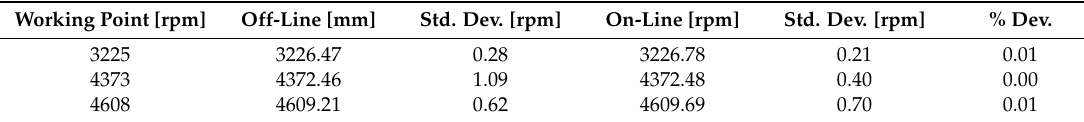
Table 5. Average rotation speed obtained for 10 revolutions with filtered signals.